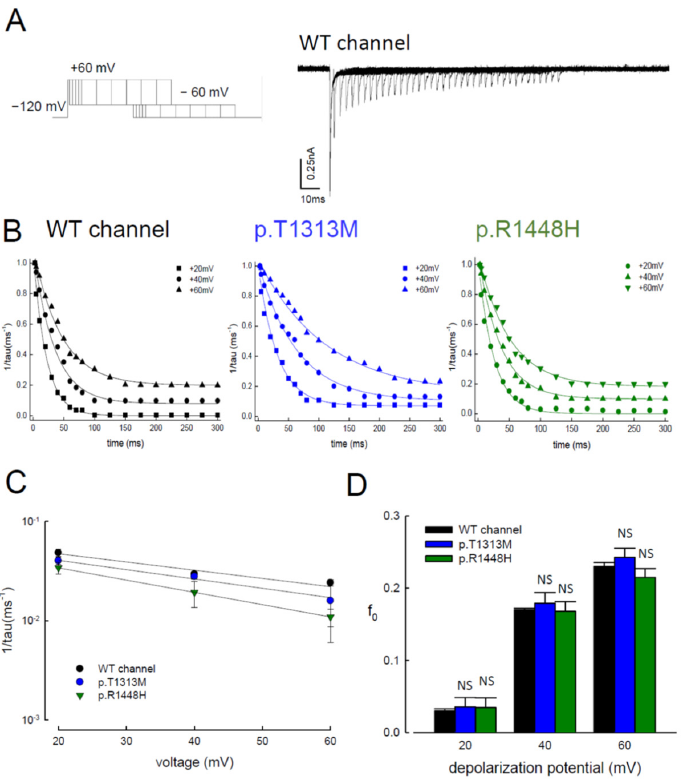
Figure 7. Resurgent Na + Currents Decreased with Prolonged Depolarization Prepulses. ( A ) The cell was first held at − 120 mV and then stepped to a gradually lengthened depolarization prepulse at +60 mV before stepping to − 60 mV for ~300 ms to document the resurgent Na + currents. The resurgent Na + currents decreased with the lengthening of the prepulse in the WT Na v 1.4 channels. ( B ) The normalized amplitude of the resurgent Na + currents (normalized to the first current in each series) was plotted against the length of the prepulse (to +20, +40, and +60 mV, according to the protocol in Figure 7A). The lines were fitted to the data points using the following formula: normalized resurgent currents = (1 − f 0 ) × exp [ − (x − 4)/ τ ] + f 0 , where x is the prepulse length in ms for the WT, p.T1313M, and p.R1448H mutant Na v 1.4 channels at different depolarization potentials. ( C ) The inverse of the time constant in Figure 7B was plot- ted against the prepulse voltage using a semi-logarithmic scale. The data were fitted with the following equation: 1/tau (V) = 0.069 × exp( − 0.5 V/25) ms − 1 , 0.069 × exp( − 0.48 V/25) ms − 1 , and 0.064 × exp( − 0.8 V/25) ms − 1 for the WT, p.T1313M, and p.R1448H mutant Na v 1.4 channels, respec- tively, where V is the prepulse potential in mV. ( D ) The f 0 (the residual resurgent Na + currents) in Figure 7B were plotted against different depolarization potentials in the WT, p.T1313M, and p.R1448H mutant Na v 1.4 channels. There was no significant difference between the channels at each voltage ( n = 5; N.S., no statistically significant